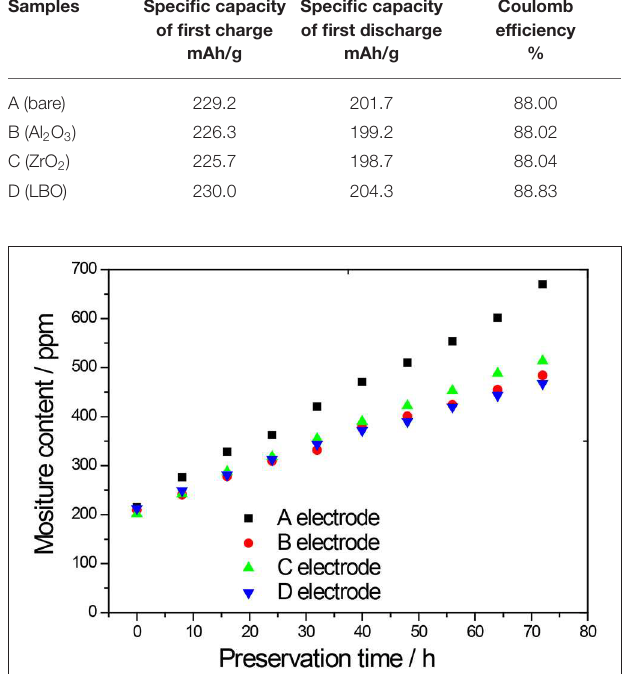
TABLE 2 | First charge and discharge capacities and Coulomb efficiencies of the coin LIB with NCM811 and NCM811 coated by Al 2 O 3 , ZrO 2 , and LBO. Samples